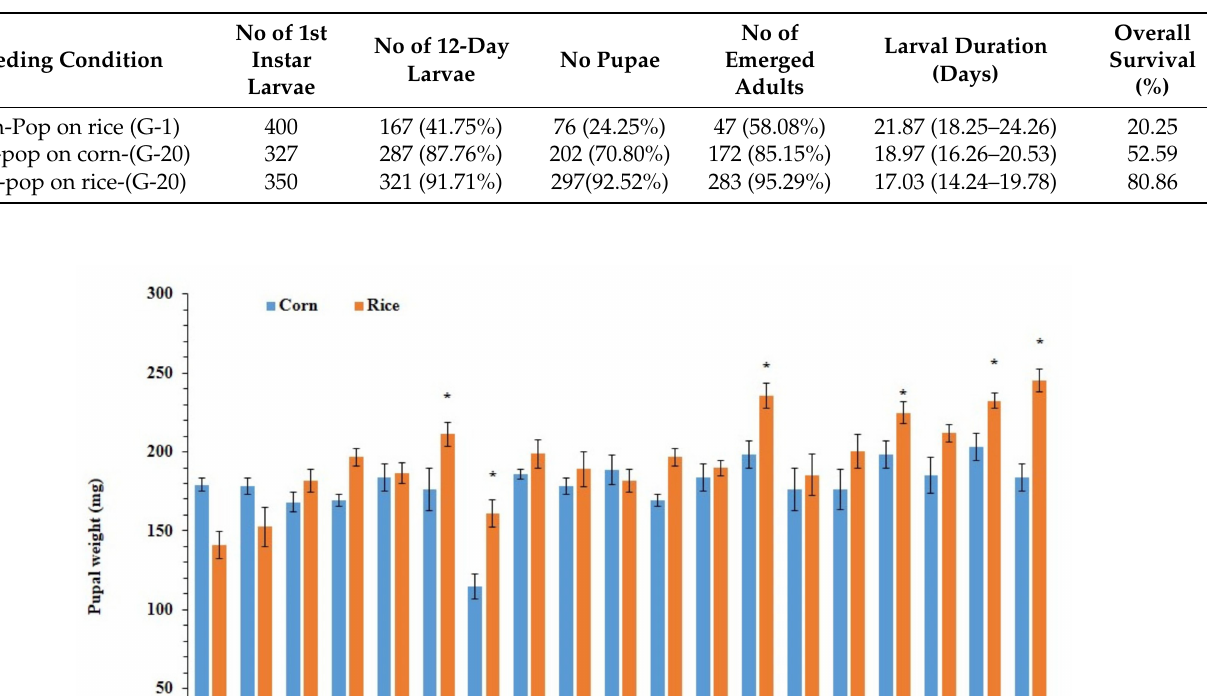
Table 1. Survival and development of Spodoptera frugiperda after rearing on primary and alternative host plants for 20 generations. Corn- pop, Rice-pop and C-R-pop (After 20 generation the corn population was fed on rice for one generation (C-R-female).